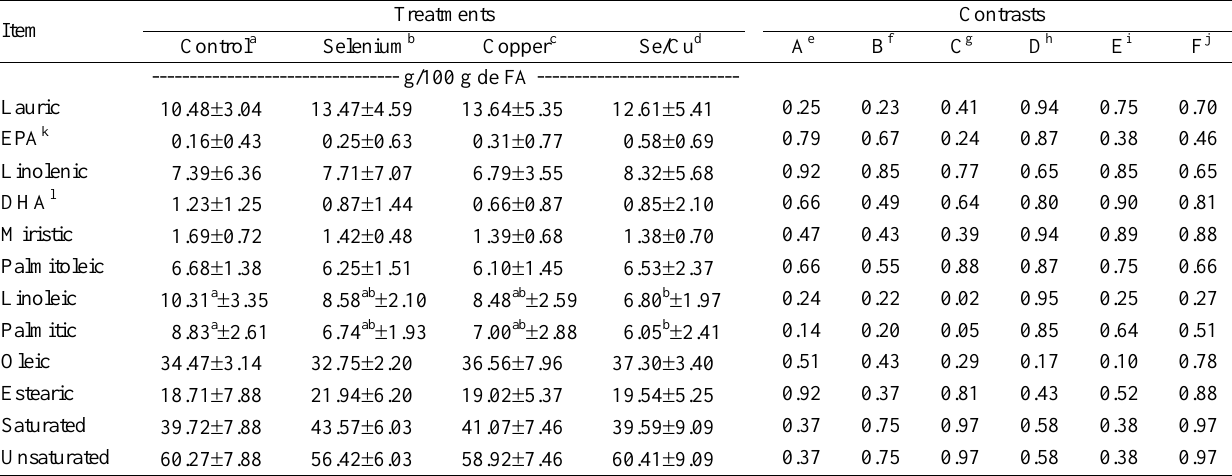
Table 3. Profile of fatty acids in Longissimus dorsi muscle of cattle receiving control diet, selenium (2 mg/kg of DM), copper (40 mg/kg of DM) and selenium (2 mg/kg of DM)/copper (40 mg/kg of DM) Treatments Contrasts Item Control